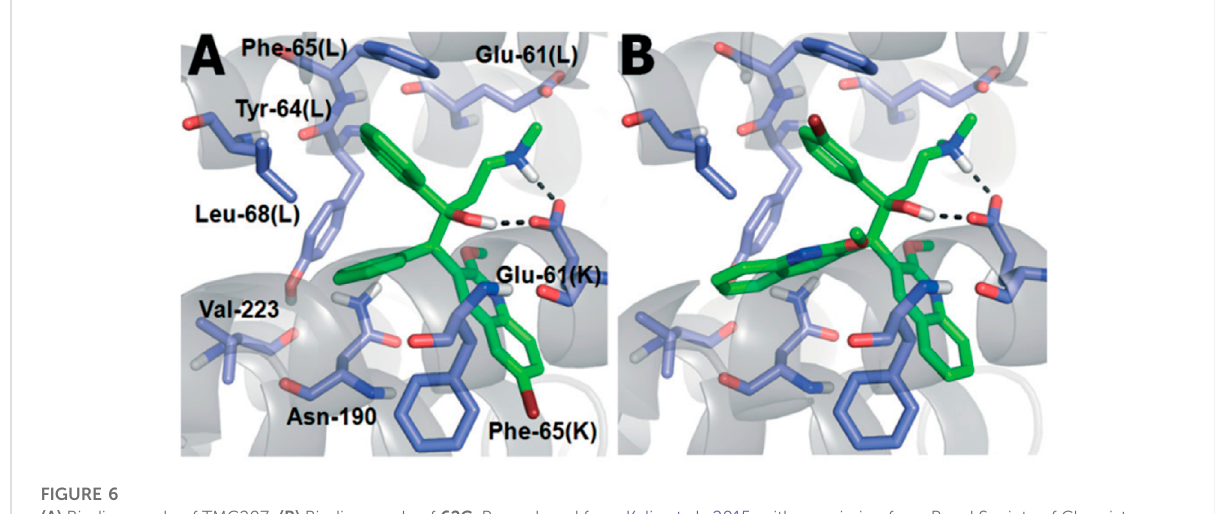
FIGURE 6 (A) Binding mode of TMC207; (B) Binding mode of 62C . Reproduced from Kalia et al., 2015, with permission from Royal Society of Chemistry, Copyright